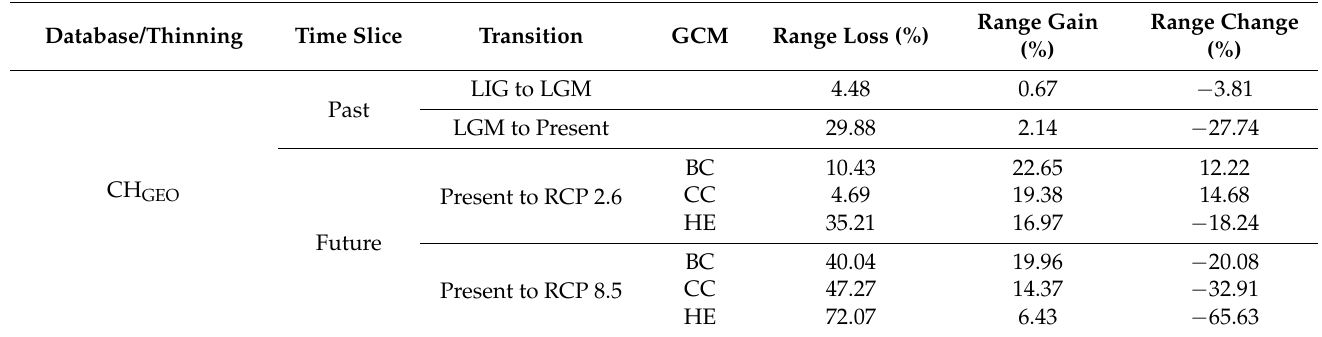
Table 2. Percentages of range loss and gain, a overall range change for past and future projections of Ophrys helenae distribution. For the past, Last Interglacial and Last Glacial Maximum (LIG and LGM, respectively) are presented, while for the future, all selected Global Circulation Models (GCMs) and Representative Concentration Pathways (RCPs) are presented (BC: BCC-CSM-1, CC: CCSM4, HE: HadGEM2-ES). The presented values are for the CHELSA climatic database, and for the geographical thinning procedure (CH GEO